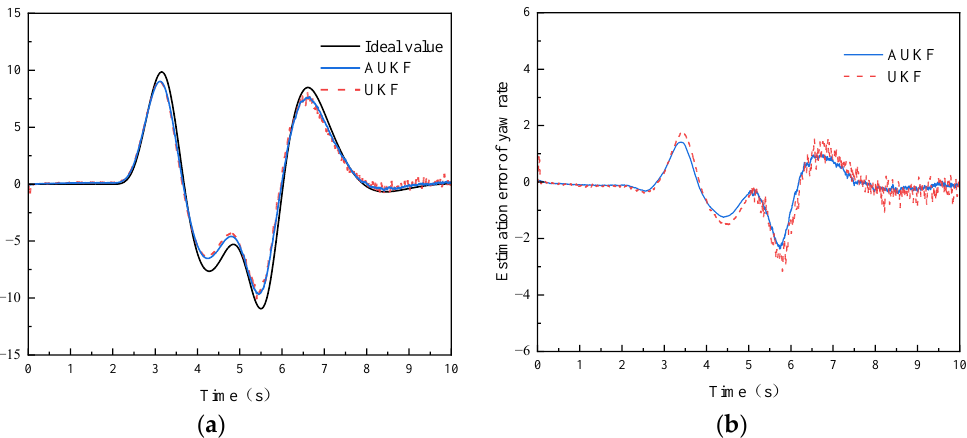
Figure 6. Simulation results of yaw rate. ( a ) Comparison of estimated results and ( b ) comparison of estimated error.